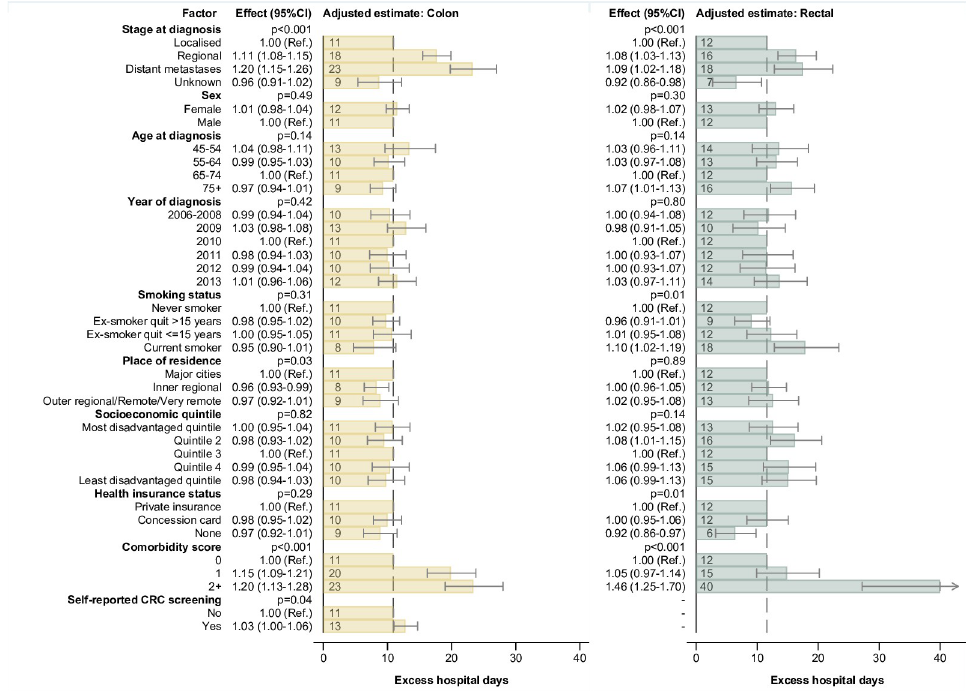
Fig 4. Multivariable adjusted excess hospital days for colon and rectal cancer in the initial phase of care. Notes: The dashed vertical line is the adjusted excess hospital days for a case in the reference category for all characteristics (i.e. 11 days for colon cancer and 12 days for rectal). For each category of a characteristic, the estimate shown reflects the adjusted excess days for a case with all other characteristics in the reference category. To allow regression with non- negative values, the models were constructed using an offset of +50 days; this offset was then deducted to obtain the adjusted estimates shown in the